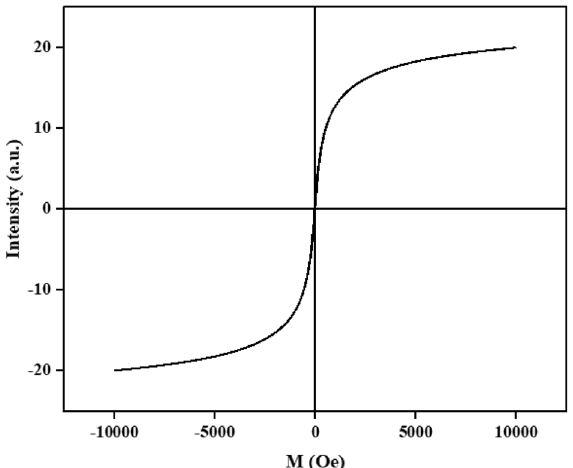
Figure 10. VSM analysis of Ps@Tet-Cu(II)@Fe 3 O 4 .